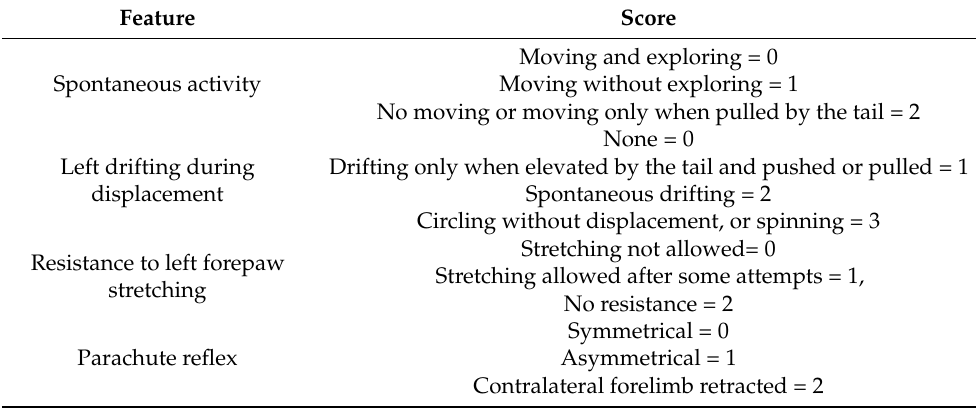
Table 3. Bederson’s neurological score system. Total score ranges from 0 to